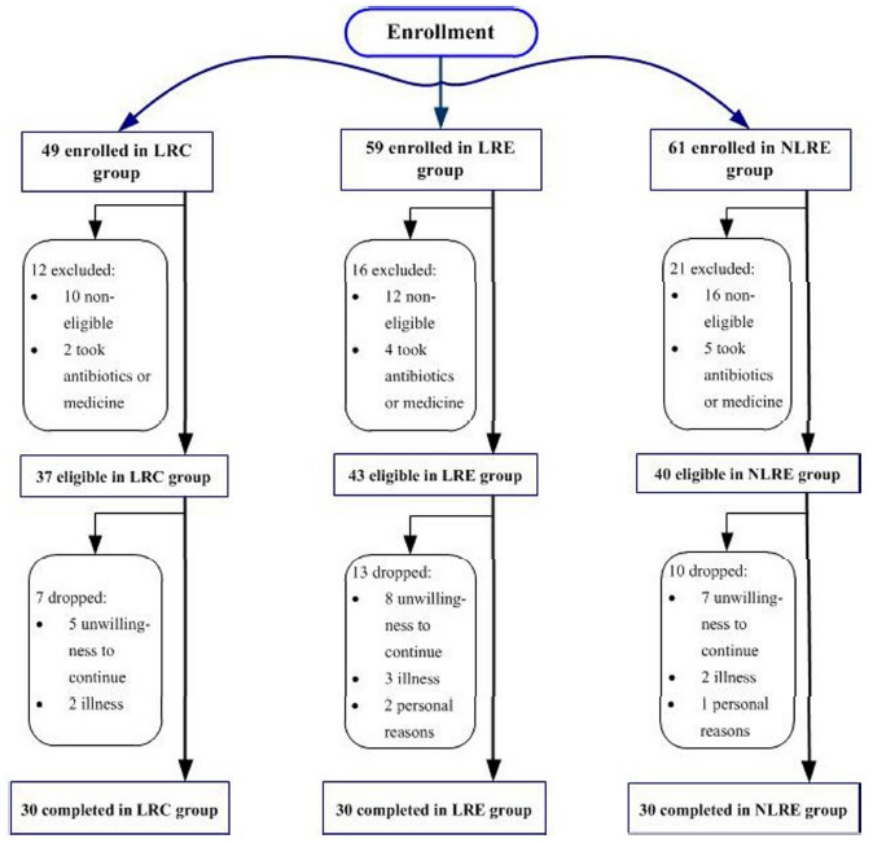
Figure 1. Flow diagram of participants during the study.